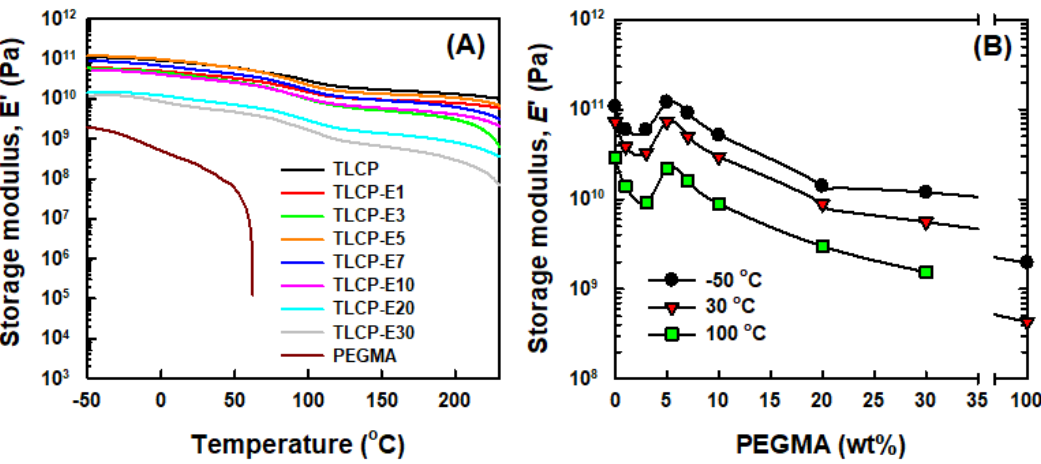
Figure 10. ( A ) Storage modulus vs. temperature and ( B ) storage modulus vs. PEGMA content curves of TLCP, PEGMA, and TLCP/PEGMA blends.